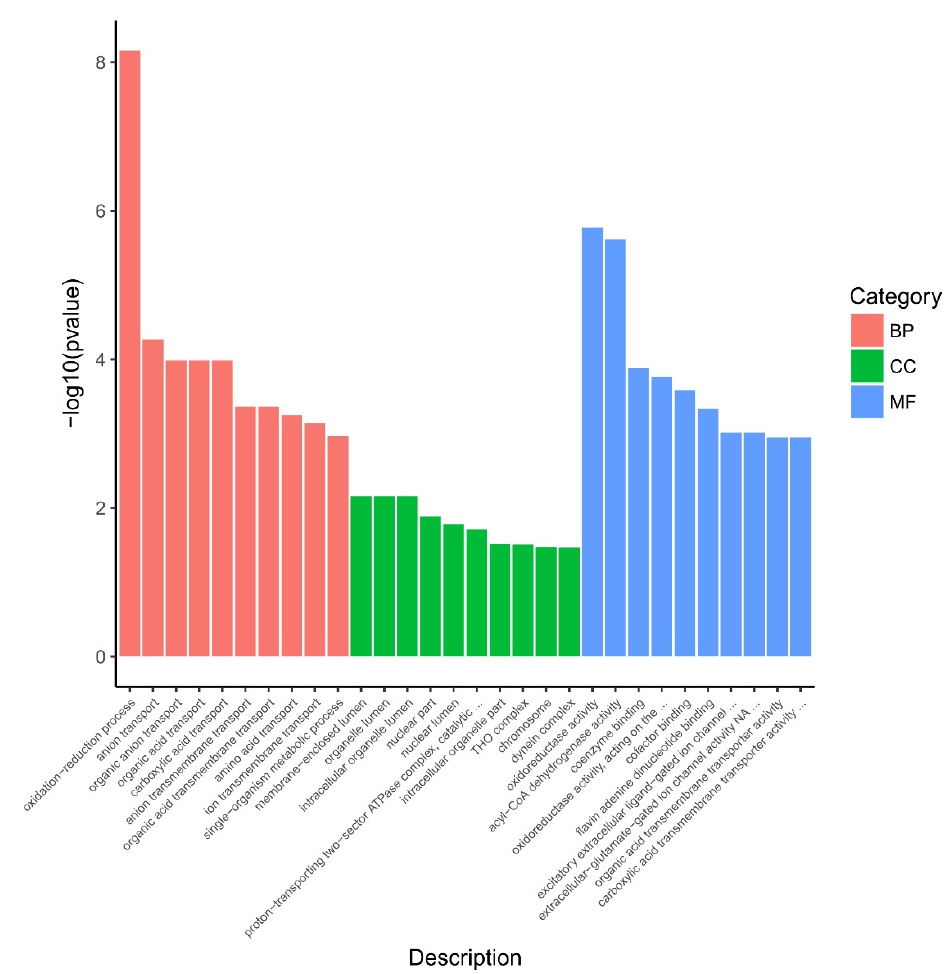
Figure 3. Significantly enriched Gene Ontology (GO) terms of differentially expressed genes. BP: biological process, CC: cellular component, MF: molecular function.